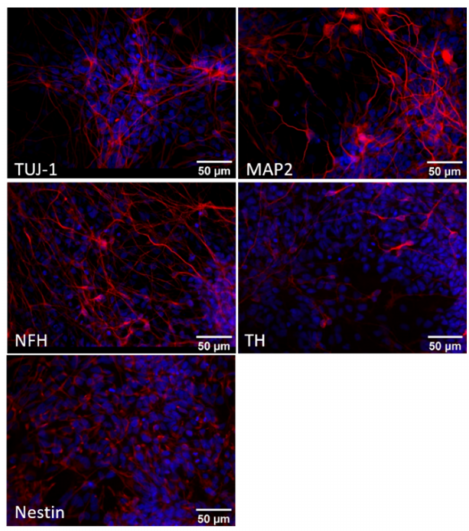
Figure 4. Characterisation of iPSCs differentiated for 45 days into dopaminergic neurons. Repre- sentative immunofluorescence images of human iPSCs-derived dopaminergic neurons at day 45 of differentiation. Cells were stained (red) for the neuronal markers β -III-tubulin (TUJ1), neurofilament H (NF-H), microtubule-associated protein 2 (MAP2) and tyrosine hydroxylase (TH) and for the neu- ronal precursor marker nestin. Cell nuclei were stained with Hoechst (blue). Images were acquired at 400 ×